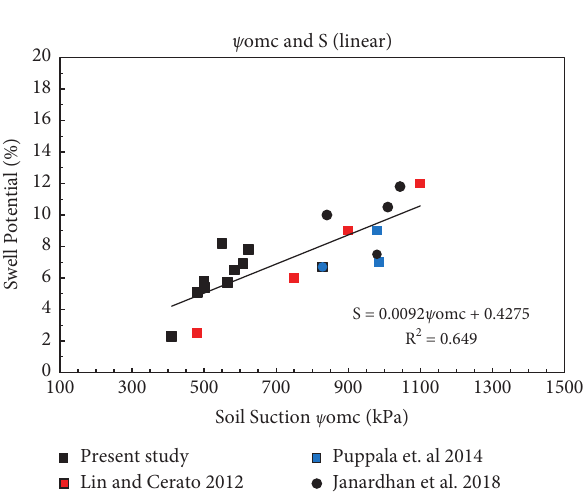
Figure 11: Linear correlation between swell potential and matric suction.